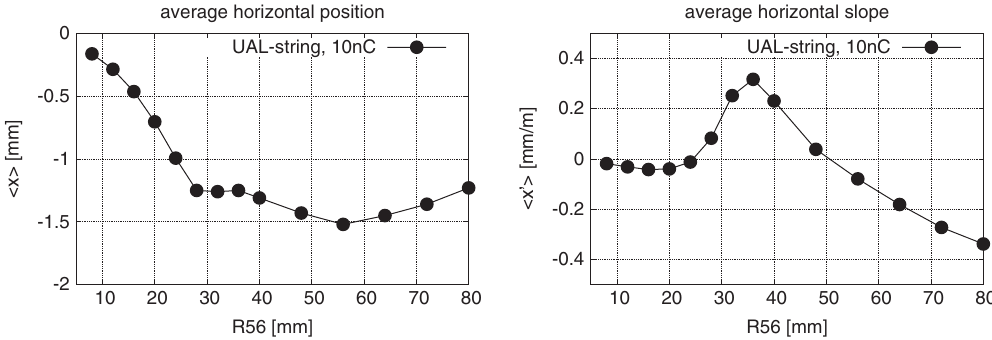
FIG. 7. Charge-dependent bunch steering for the Q ¼ 10 nC data set. The upper and lower graphs give, respectively, the mean bunch displacement and slope of the bunch centroid at the beam line